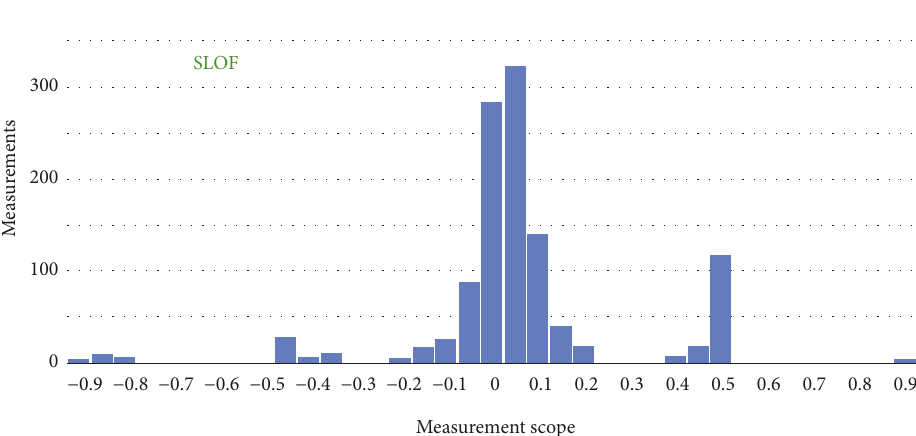
Figure 6: Distribution of measurement scores for the SLOF algorithm. Extreme values and outliers are not shown; the distribution shows 936 (of 1152) or 81% of all measurement scores for SLOF .